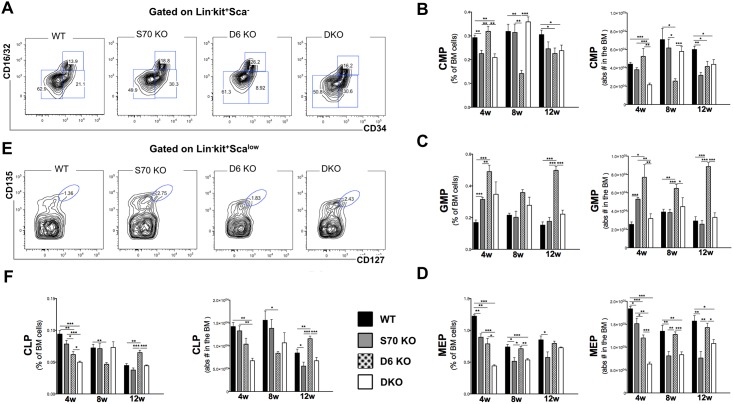
Lymphoid and myeloid progenitor analysis in the bone marrow of Swap-70-/-, DEF6-/- and double knock-out mice.(A) and (E) Representative FACS plots of freshly isolated BM from wt, Swap-70-/- (S70 KO), Def6-/- (D6 KO) and Swap-70-/-Def6-/- (DKO) 8-week old mice. Upper plots (A) subgated DAPI-Lin-kit+Sca- BM cells to discriminate common myeloid progenitors (CMP, CD34+CD16/32-), granulocyte-monocyte progenitors (GMP, CD34+CD16/32+) and megakaryocyte-erythroid progenitors (MEP, CD34-CD16/32-). Lower plots (E): subgated DAPI-Lin-kit+Scalow to discriminate common lymphoid progenitors (CLP, CD135+CD135+?). Percentages shown are of parental gate. (B) Relative (on the left) and absolute (on the right) CMP cell numbers in the BM of wt (black bars), SWAP-70 (grey bars) and DEF6 (dotted bars) single and DKO (white bars) of different ages (4, 8 and 12 weeks old) quantified by FACS. (C) Relative (on the left) and absolute (on the right) GMP cell numbers in the BM of wt, SWAP-70 and DEF6 single and DKO of different ages quantified by FACS. (D) Relative (on the left) and absolute (on the right) MEP cell numbers in the BM of wt (black bars), SWAP-70 (grey bars) and DEF6 (dotted bars) single and DKO (white bars) of different ages (4, 8 and 12 weeks old) quantified by FACS. (E) Relative (on the left) and absolute (on the right) CLP cell numbers in the BM of wt (black bars), SWAP-70 (grey bars) and DEF6 (dotted bars) single and DKO (white bars) of different ages (4, 8 and 12 weeks old) quantified by FACS. At least 4 mice of each genotype per group were analyzed, in many instances >10 mice were analyzed. Mean ± SD. *P<0.05, **P<0.01, ***P<0.005.